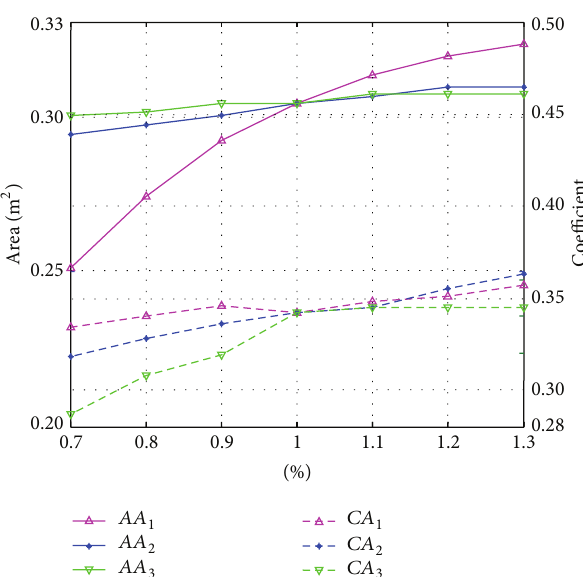
Figure 21: Relationship about joints angles, attainable area, and Manipulator Omnidirectional